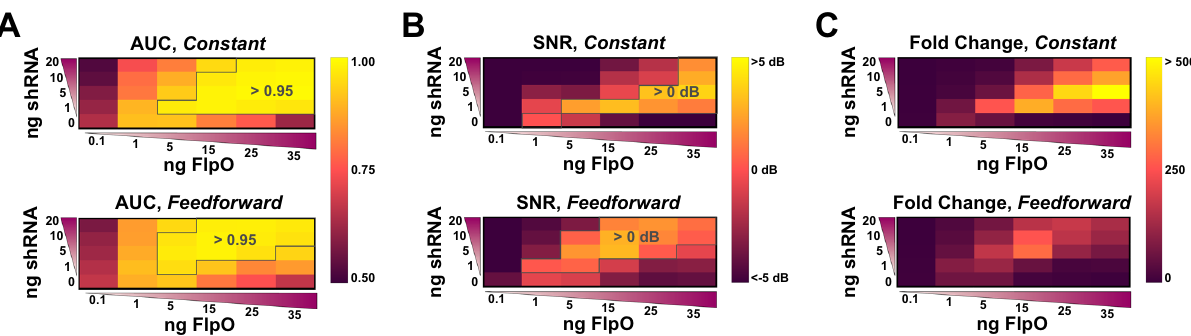
Fig. 2 Flp:shRNA parameter space highlights divergent performance of each topology. AUC ( A ), SNR ( B ), and fold change ( C ) heat maps highlight trends among each circuit topology. Outlined sections in the AUC and SNR heat maps represent topologies achieving AUC > 0.95 and SNR > 0 dB, respectively. Data represents the average of three technical replicates ( n = 3) of circuits transiently transfected into HEK293FT cells 48 h after transfection/induction. Induced cell media contains 225 nM